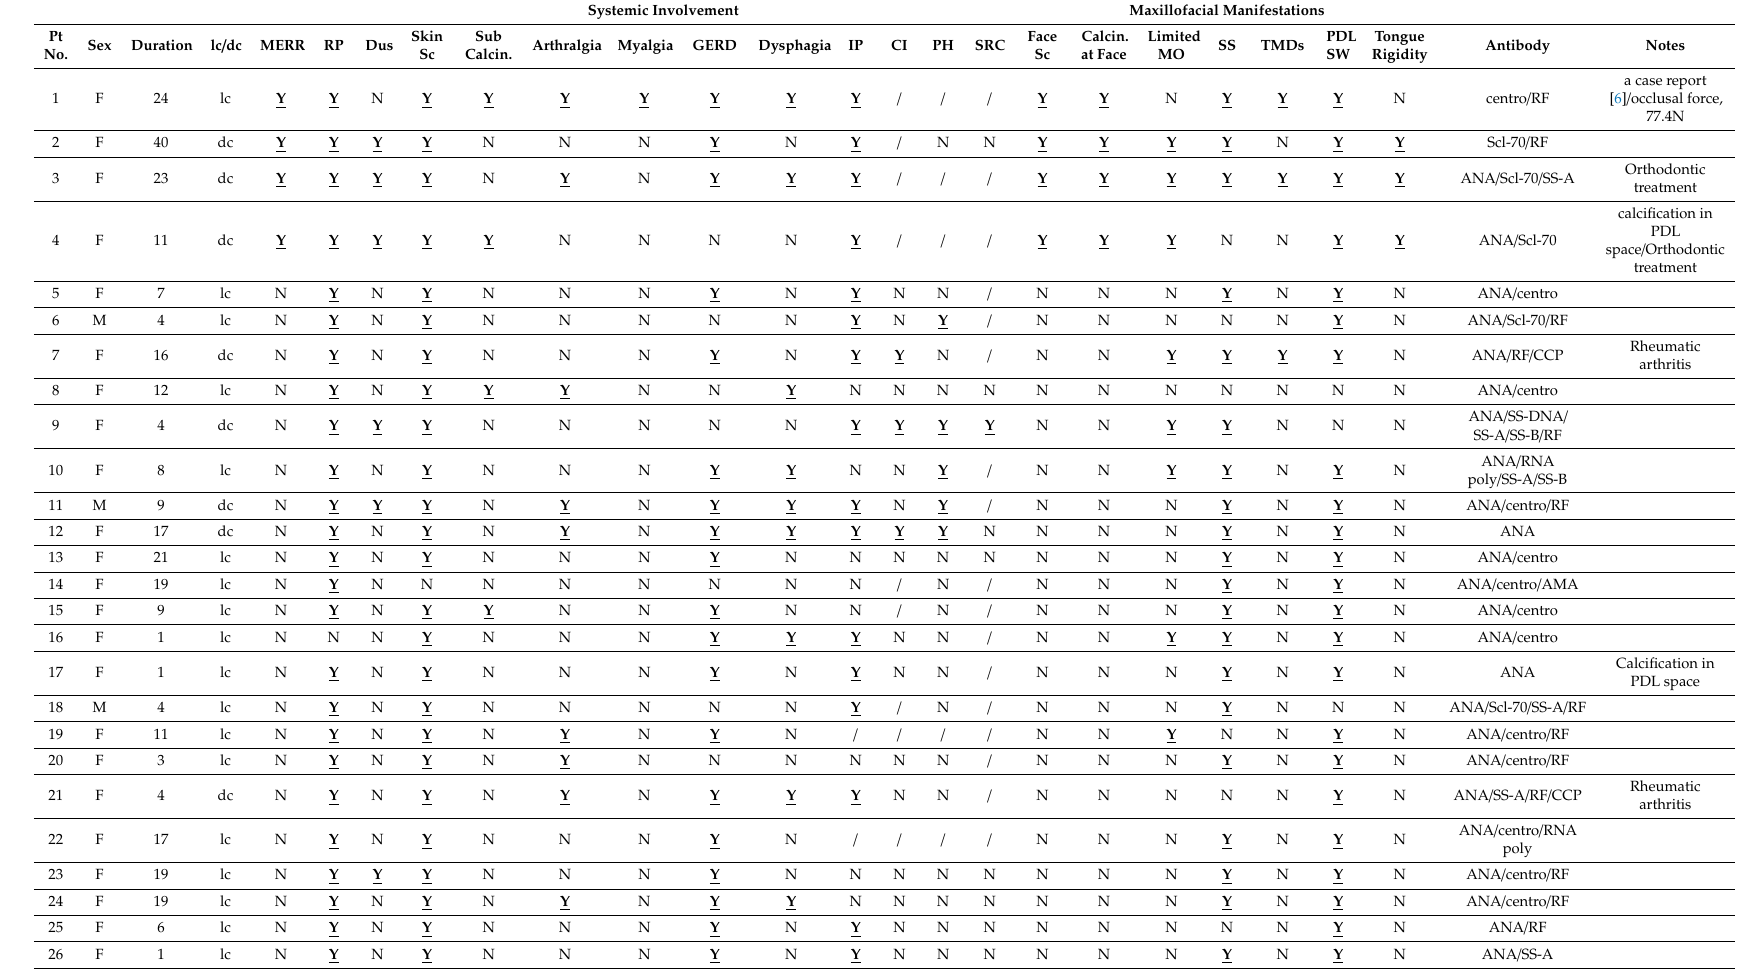
Table 2. A summary of results on systemic and maxillofacial manifestations in all SSc